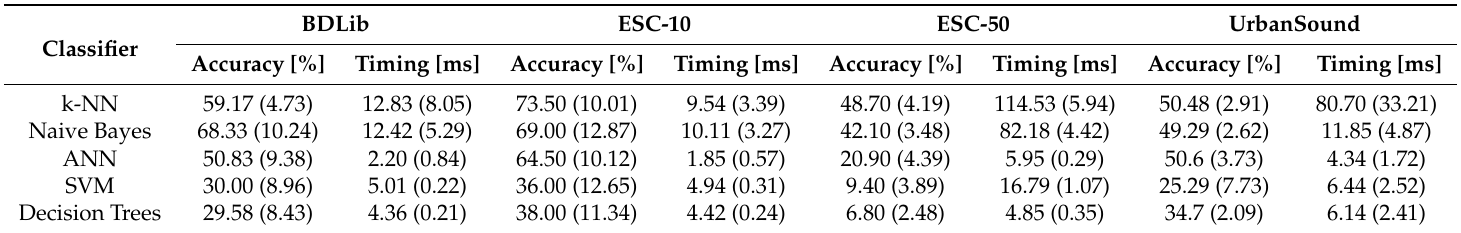
Table 14. Experimental values obtained in the Raspberry Pi. The classifiers’ accuracy per dataset and the average execution time of the classifiers with default configuration are measured. Timing values are expressed in milliseconds. The values in brackets are the Standard Deviation